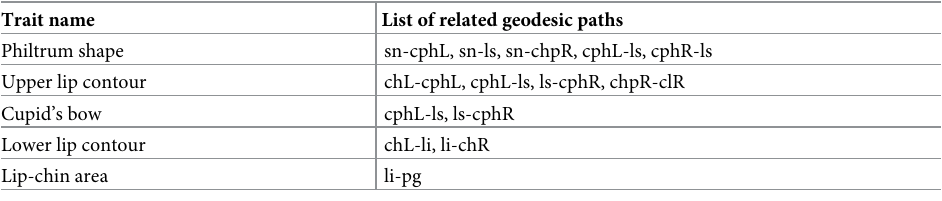
Table 2. List of geodesic paths defining morphological lip